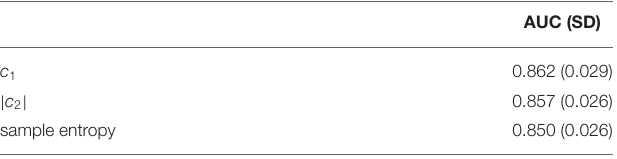
TABLE 4 | The area under the ROC curve (AUC) for c 1 , | c 2 | , and sample entropy averaged scale 1–5.